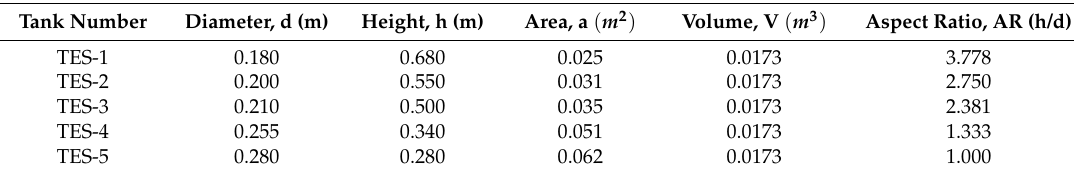
Table 1. Geometrical dimensions of the five different tanks